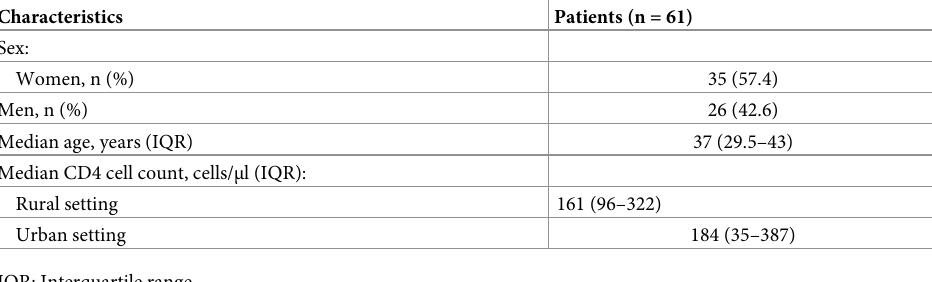
Table 1. Demographic and clinical characteristics of treatment na ï ve patients (n = 61) recruited between Febru- ary-April 2017.